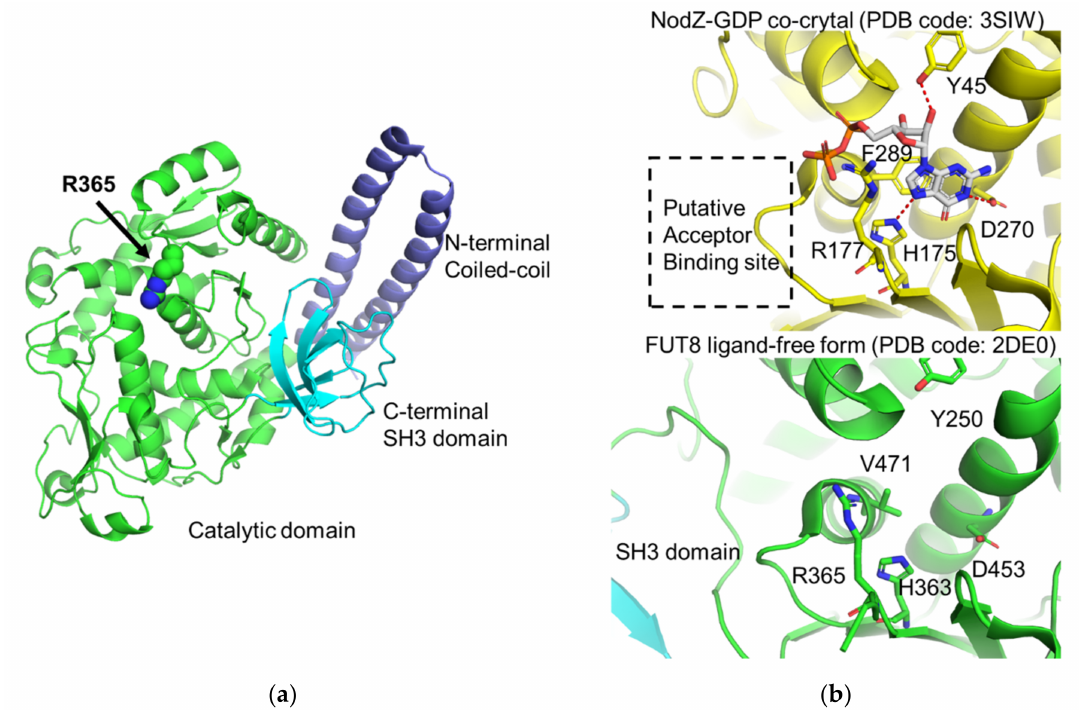
Figure 5. Crystal structure of the human FUT8. ( a ) Overall structure of human FUT8 catalytic domain (PDB code: 2DE0). N-terminal, catalytic and C-terminal SH3 domains are colored with blue, green, and cyan, respectively. The side chain of R365, which is the putative catalytic center is shown in sphere model. The nitrogen atoms of R365 are highlighted in blue. ( b ) Structural comparison between bacterial NodZ-GDP complex (upper panel, PDB code: 3SIW) and human FUT8 in ligand-free form (lower panel). The putative acceptor-binding site is depicted as a black-dotted box. The GDP and amino acid residues which interact with GDP in NodZ are shown in stick models. The hydrogen bonds are depicted in red dotted lines. The carbon atoms of NodZ and GDP, nitrogen, oxygen and phosphorus atoms are colored in yellow, grey, blue, red, and orange, respectively. The corresponding residues Fut8 are also